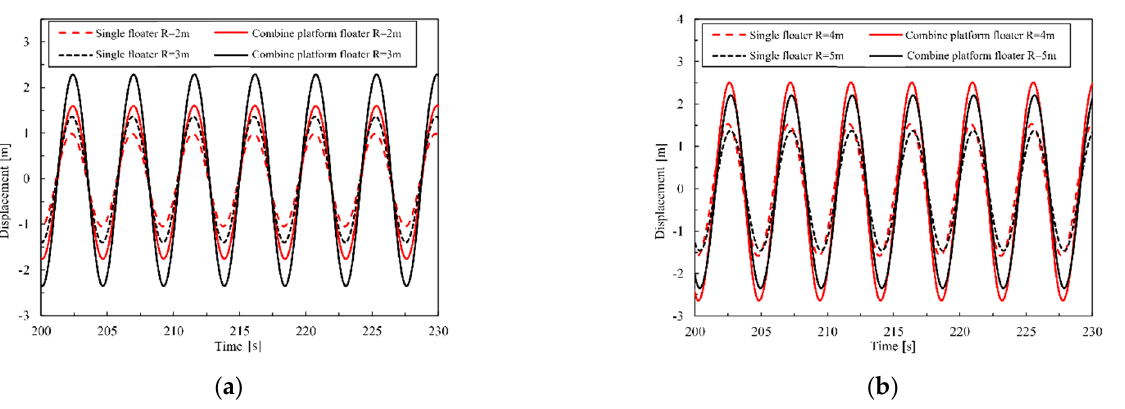
Figure 10. Displacement comparison of floaters with different sizes under regular waves: ( a ) R = 2 m & R = 3 m; ( b ) R = 4 m & R = 5 m.